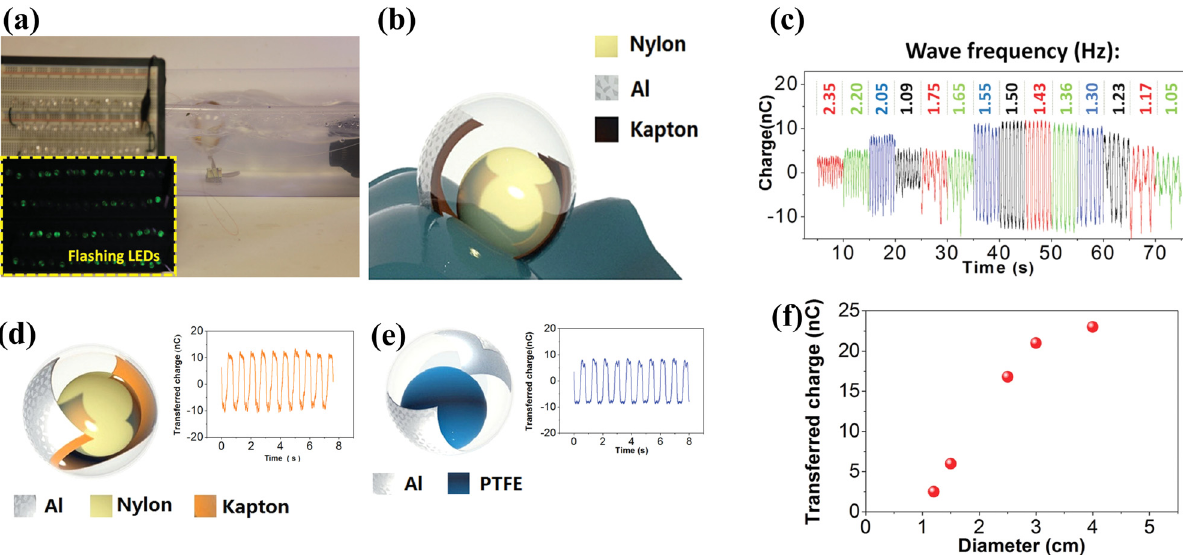
Figure 2: ( a ) Photograph of the RF - TENG pool test lighting LED, ( b ) schematic diagram of an RF - TENG device, ( c ) the relationship between the charge transferred by the RF - TENG device with a diameter of 4 cm and the wave frequency, ( d ) the schematic of the nylon/Kapton device and measured the transfer charge, ( e ) the schematic of a PTFE/Al device and measured the transferred charge, and ( f ) the relationship between the diameter of the experimentally tested ball and the transferred charge [ 49 ]